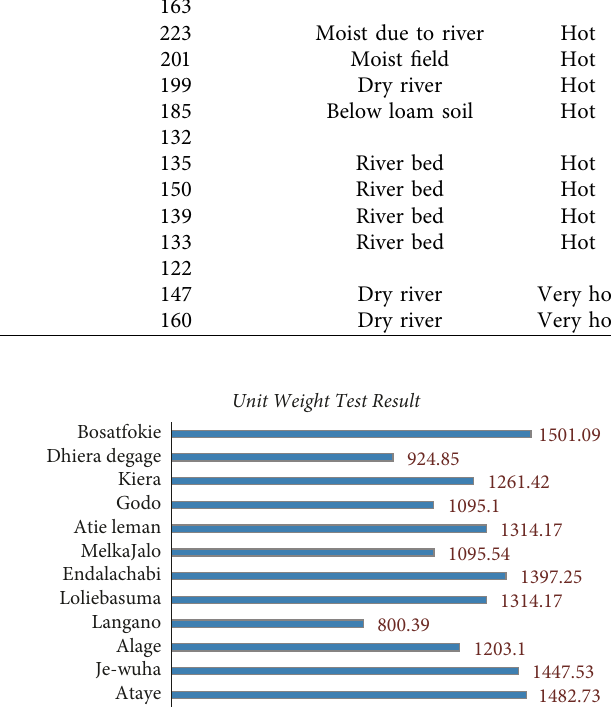
Figure 5: Unit weight (source: test during this